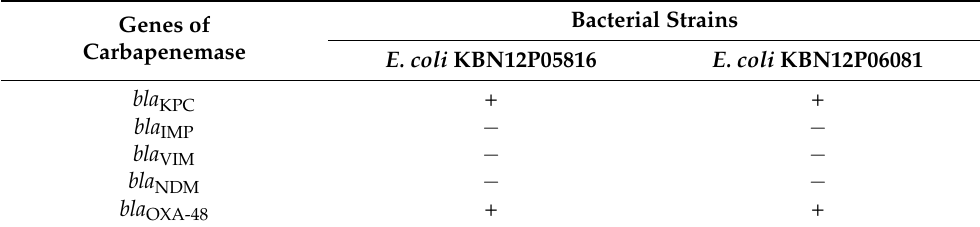
Table 2. Detection of carbapenemase genes in E. coli strains as determined by PCR. Bacterial Strains Genes of Carbapenemase E. coli KBN12P05816 E. coli KBN12P06081 bla KPC + + bla IMP